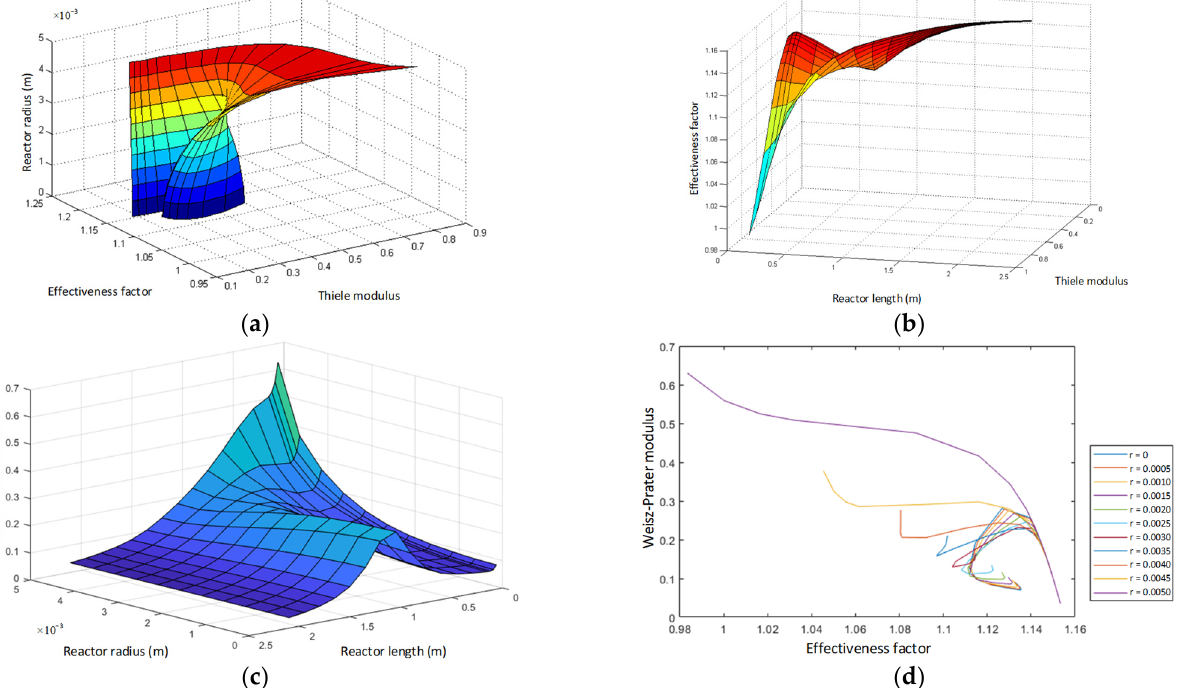
Figure 4. Graphical representation of the profiles inside the catalyst particle: ( a ) graphical representation of the effectiveness factor as a function of the Thiele modulus and the radius of the reactor, ( b ) graphical representation of the effectiveness factor as a function of the Thiele modulus and the length of the reactor, ( c ) graphical representation of the Weisz–Prater modulus factor as a function of the radius and length of the reactor, and ( d ) graphical representation of the Weisz–Prater modulus as a function of the effectiveness factor (obtained from Tables A3 and A4).